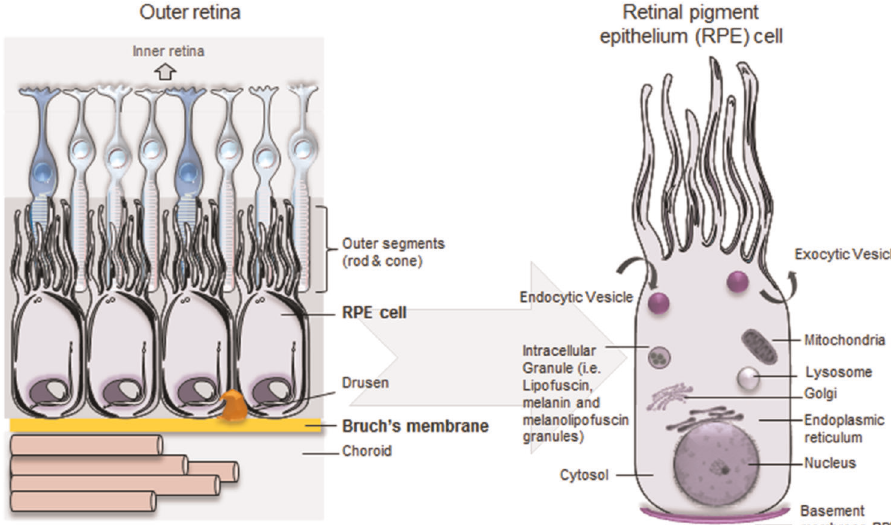
Fig. 1 Compartments created in the CellDesigner platform in line with the structure and function of the outer retina. The outer retina lies internal to a layer of fenestrated choroidal capillaries called the choriocapillaris that supply the retina with oxygen, lipoproteins, glucose, vitamins and other nutrients, as well as removing waste substances such as carbon dioxide and lactate. The connective tissue layer between the choriocapillaris and the RPE is the Bruch ’ s Membrane. It is made up of fi ve layers containing ECM proteins and acts rather like a sieve, providing a degree of constraint to the reciprocal exchange of molecules, nutrients, fl uids, and waste products between the retina and circulation. The RPE is made up of a single layer of hexagonal cells and serves many functions. With tight junctions between the lateral surfaces, the RPE functions as part of the blood-ocular barrier, isolating the inner eye from systemic in fl uences. Separating the inner eye from circulation provides immune privilege protecting the vital cells and structures from potential damage or loss of function via in fl ammatory immune response. The RPE is responsible for the selective transport and processing of all nutrients, metabolites, signaling molecules, and waste products to and from the inner retina, including the photoreceptors. Note that compartments are not drawn to